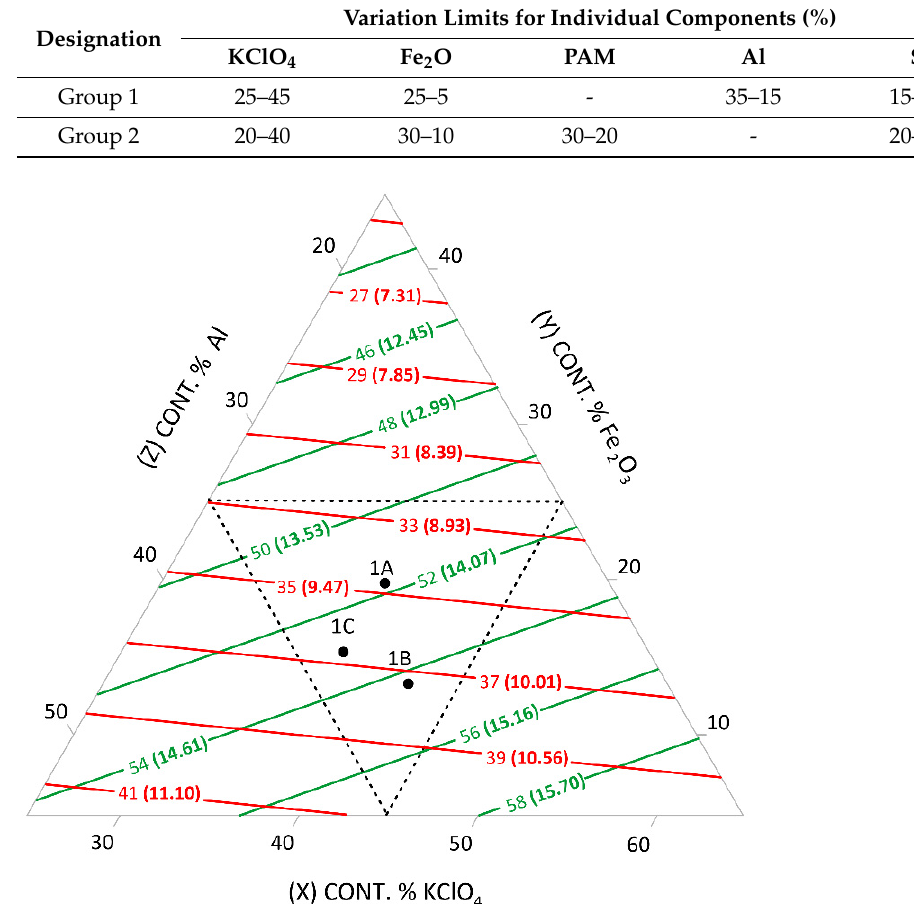
Table 4. Variation range for individual components [16].